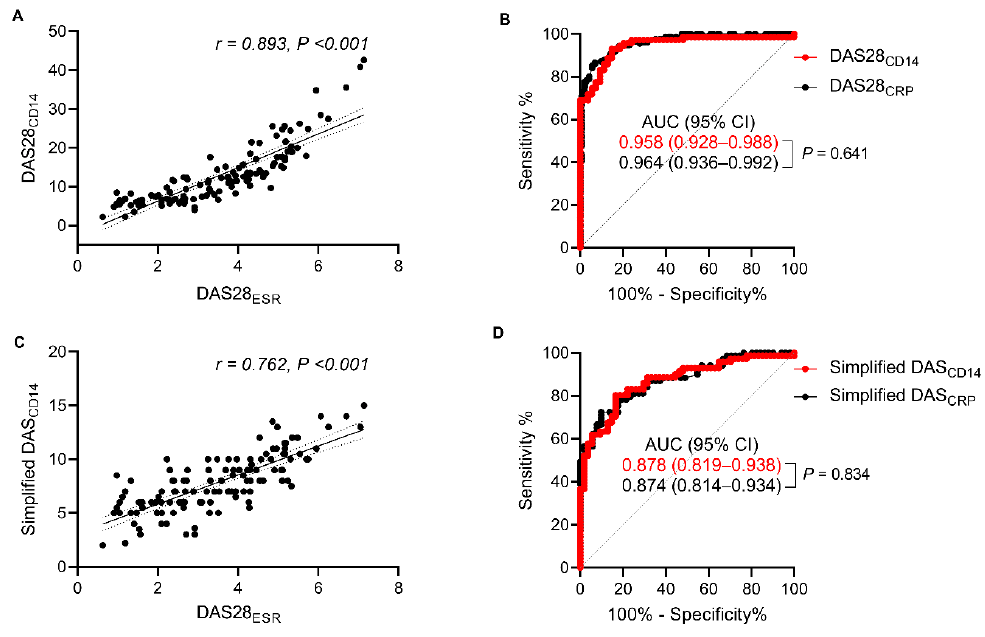
Figure 3. Diagnostic performance of the new composite indices based on CD14 concentrations. ( A ) Correlation between the DAS28 CD14 and DAS28 ESR . ( B ) Area under the receiver operating characteristic (ROC) curve (AUC) analysis of the DAS28 CD14 versus DAS28 CRP (as a comparator) for distinguishing low disease activity from moderate/high disease activity, as determined by the DAS28 ESR . The two